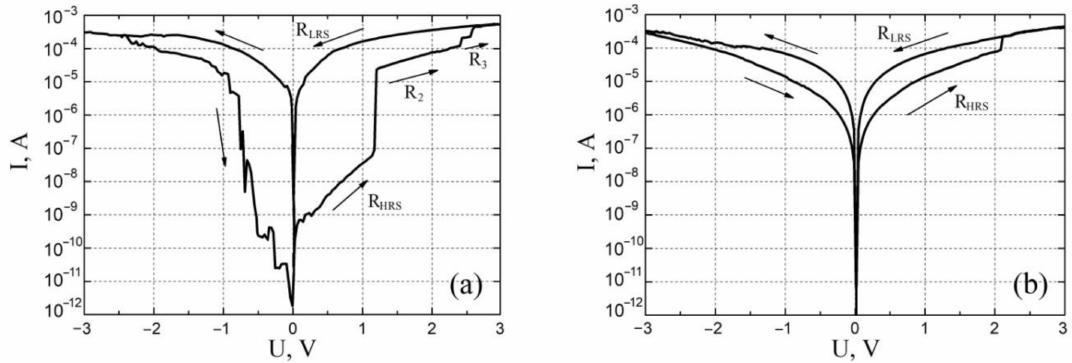
Molecules 2021 , 26 , x FOR PEER REVIEW 7 of 14 Figure 6. I-V characteristics of vanadium oxide films with different film thickness: ( a )—22.3 ± 4.4 nm; ( b )—131.7 ± 14.4 nm.